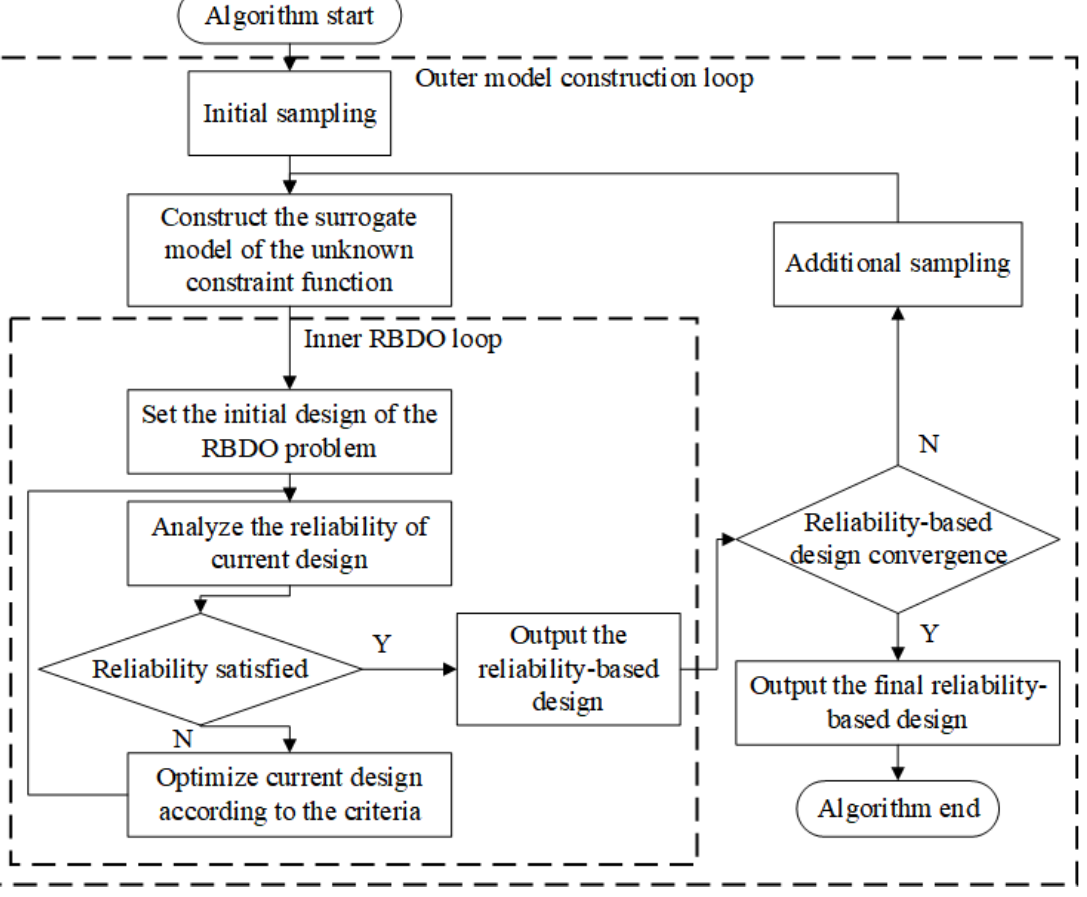
Figure 1. The solving framework of the black box RBDO